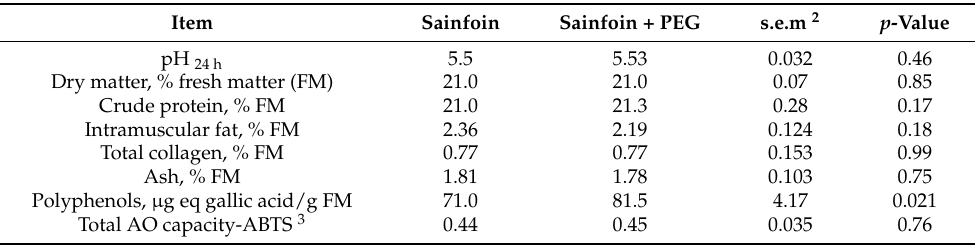
Table 3. Effect of the presence of proanthocyanidins (PAC) in the dams’ diet 1 on the pH, chemical composition and total antioxidant (AO) capacity of the meat of their suckling